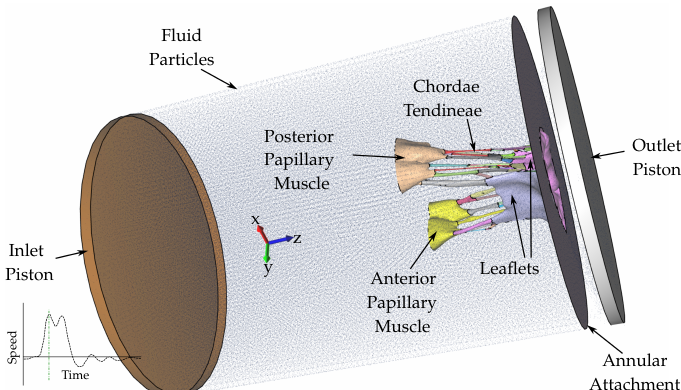
Figure 3. The fluid particles are confined in a pipe-like rigid structure surrounding the MV model and prescribed velocity boundary conditions are applied to the open ends via the use of moving pistons in